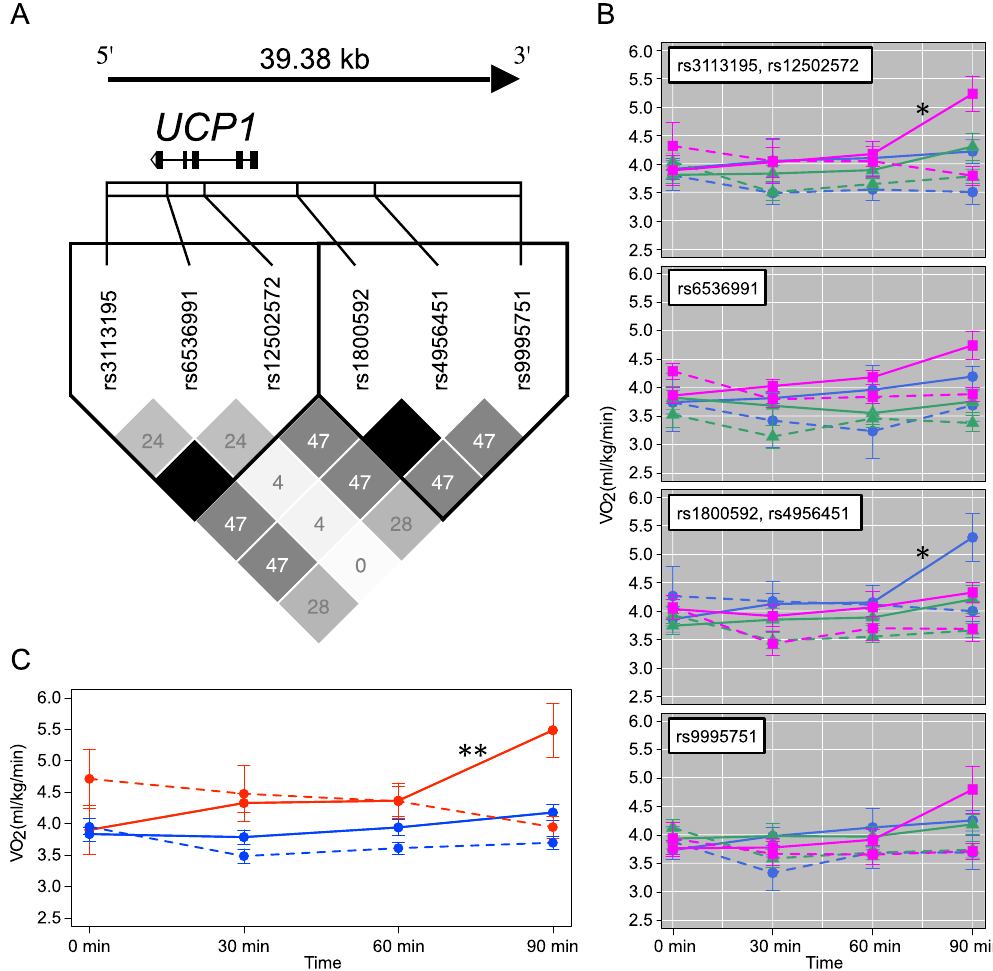
Figure 1. Physiological differences among UCP1 genotypes. ( a ) The physical positions and LD structure of UCP1 SNPs genotyped in this study. A pairwise r 2 value is shown in each square. Darker gradient color indicates higher r 2 values, and black indicates an r 2 of 1. The haplotype block defined by the Gabriel et al . method 31 is represented by the enclosure of the black line. ( b ) Time series variations of VO 2 ( + / − s.e.m.) in each SNP and that genotype. The solid and dashed lines show the changes under 16 and 28 degrees Celsius, respectively. The colors of the lines represent each genotype (blue: a homozygote of an ancestral allele; magenta: a homozygote of a derived allele; green: heterozygote of ancestral/derived alleles). ( c ) Time series variations of VO 2 ( + / − s.e.m.) between haplotypes. The solid and dashed lines show the changes under 16 and 28 degrees Celsius, respectively. The colors of the lines represent each genotype (red: a homozygote of GnGTAn haplotype; blue: a homozygote and heterozygote of other haplotypes). The asterisks indicate a significant increase compared with other genotypes ( * P < 0.05; ** P <